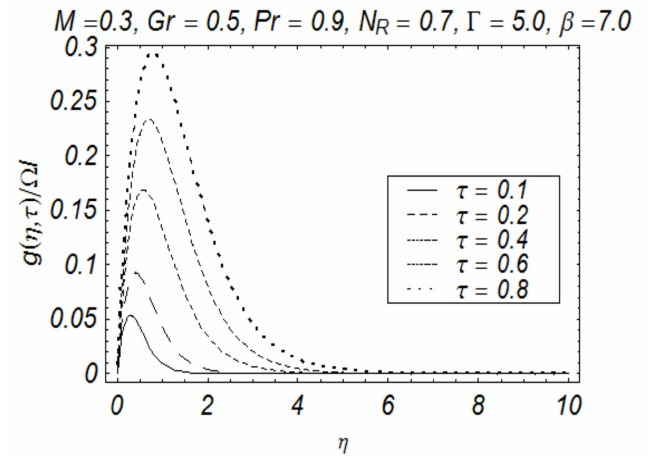
Figure 3. Indication of τ on secondary velocity.